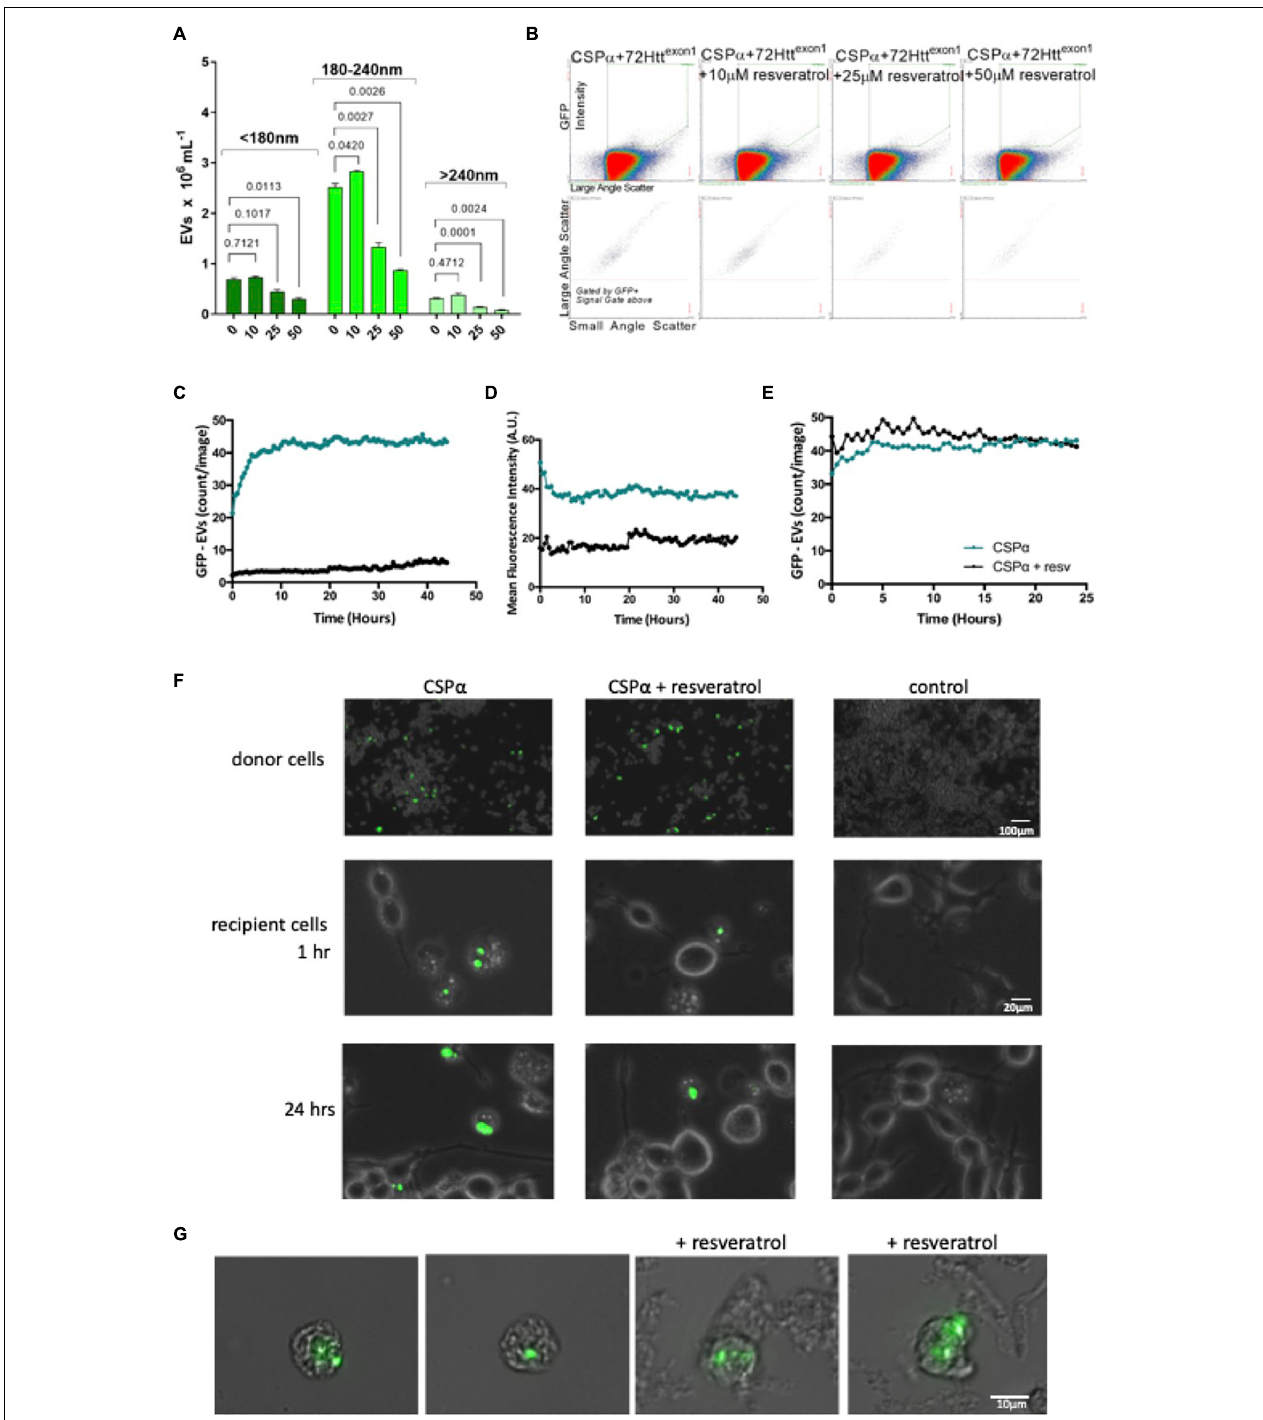
FIGURE 5 | Resveratrol reduces CSP α -EV export of mutant huntingtin. (A) Bar graph showing GFP-72Htt exon1 containing EVs released in the presence of increasing concentrations of resveratrol, p -values are indicated. (B) Flow cytometry scatter plot showing GFP-72Htt exon1 containing EVs released in the presence of increasing concentrations of resveratrol. (C,D) EVs from CAD cells co-expressing GFP-mutant huntingtin and CSP α in the absence (green) and presence of 50 µ m resveratrol (black) were applied to naïve cells in 12 well plates. (C) Number of large EVs containing GFP (puncta intensity = 1, rdiameter = 10, and mean fluorescence averaged over 9 images) and (D) fluorescence intensity of large EVs containing GFP (relative units; mean from 9 images). (E) The number of EVs expressing GFP-mutant huntingtin and CSP α were monitored for 24 h following direct application of 50 µ m resveratrol. (F) EVOS images of GFP-72Htt exon1 aggregates in donor CAD cells at the time of media collection and GFP-72Htt exon1 aggregates in recipient cells at 1 and 24 h. (G) Widefield fluorescent microscopy of EVs containing GFP-tagged huntingtin aggregates.